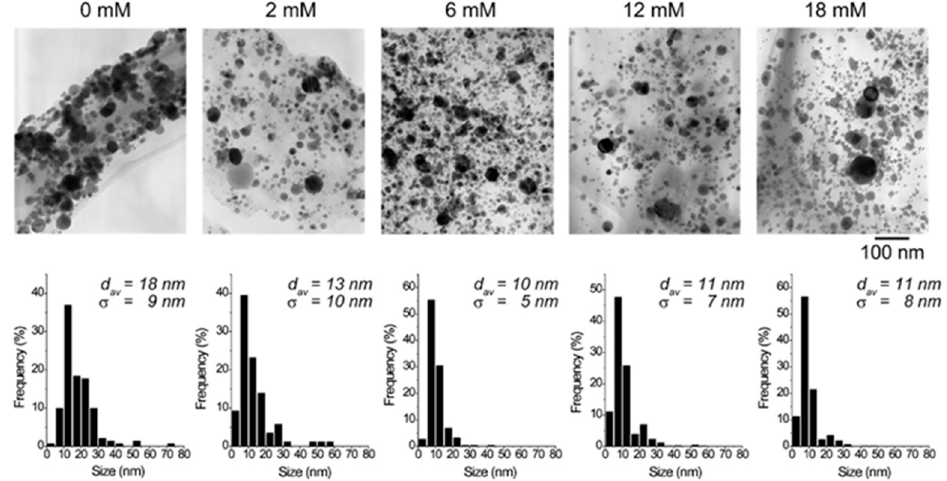
Figure 7. TEM images and the particle size distributions of silver nanoparticles prepared by laser ablation using a silver plate in PVP solutions at various concentrations. Reprinted/adapted with permission from Ref. [31]. Copyright 2008, Elsevier.